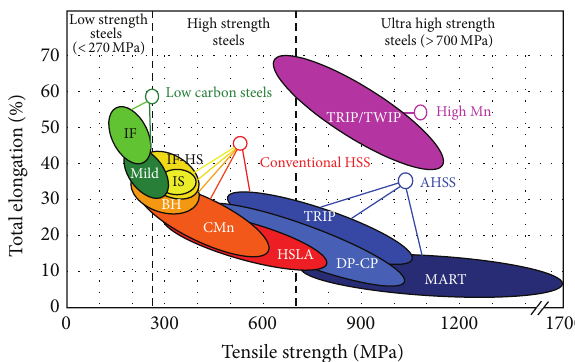
Figure 1: The so-called banana diagram representing the strength and ductility of different steel types. The areas of research for the third generation of AHSS are highlighted